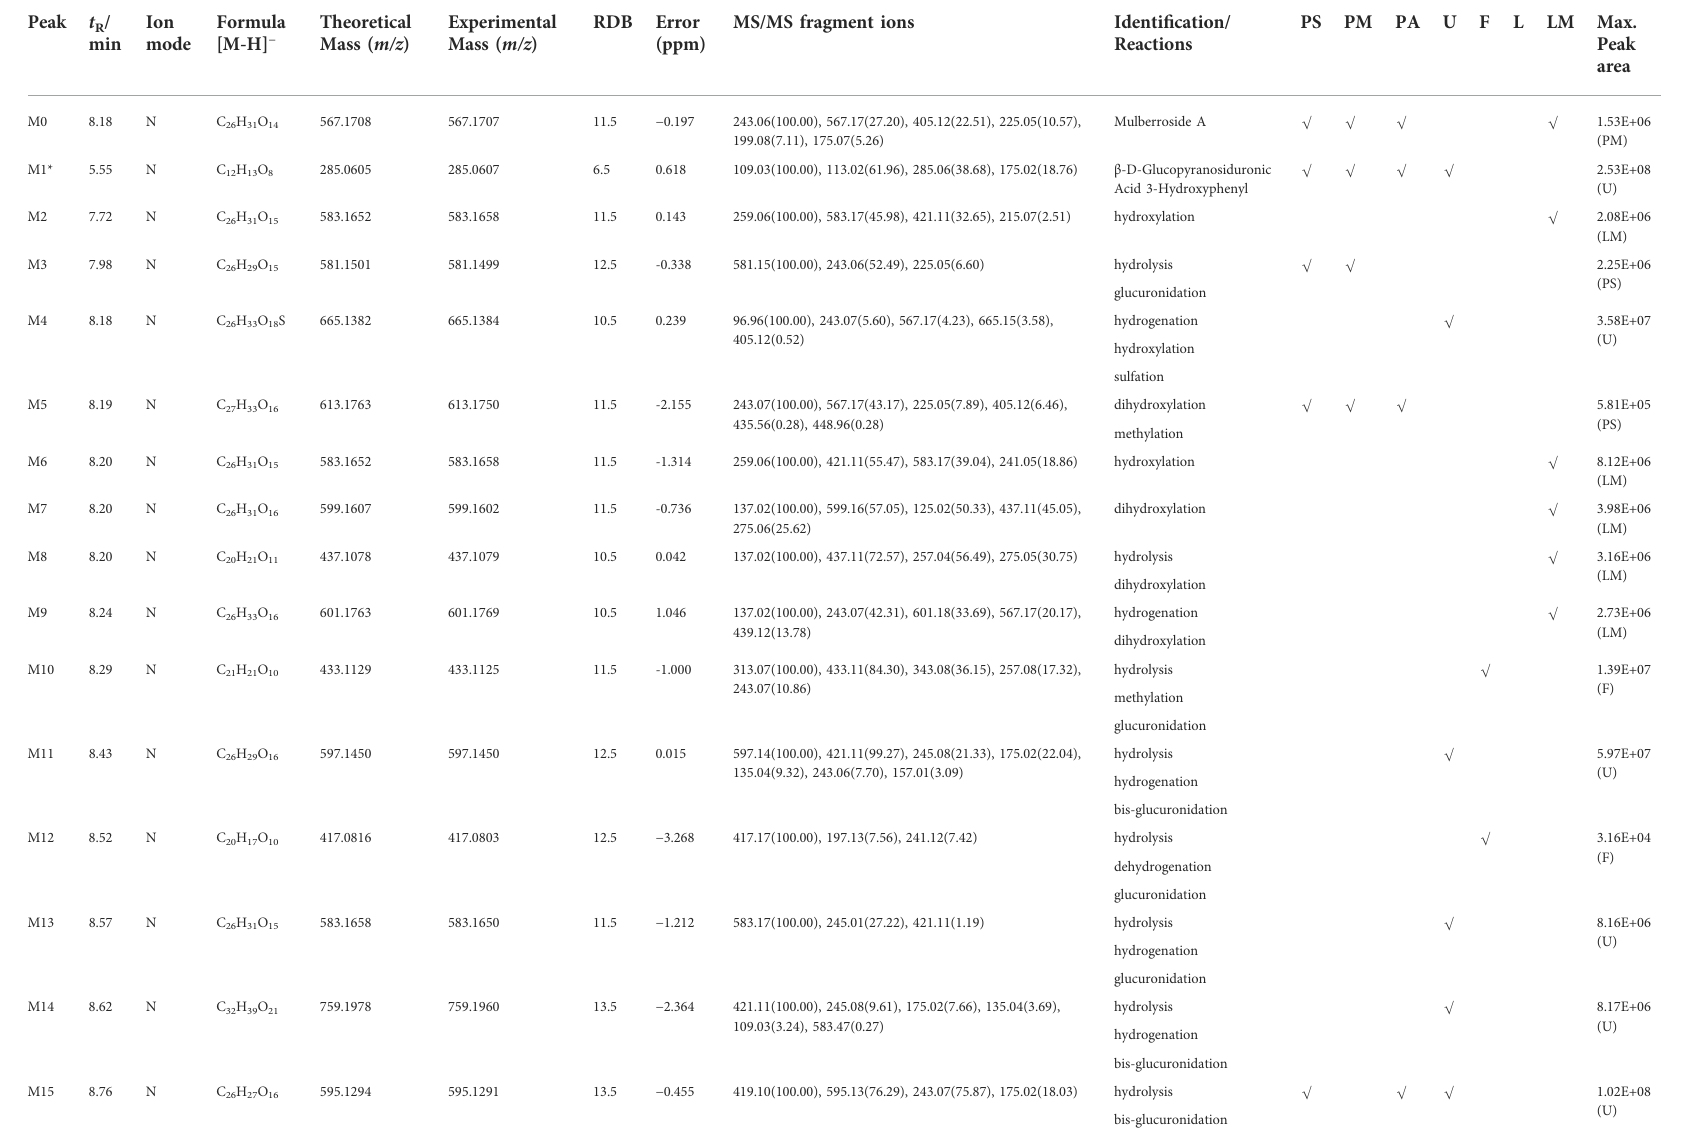
TABLE 1 Summary of mulberroside A metabolites in vivo and in vitro of